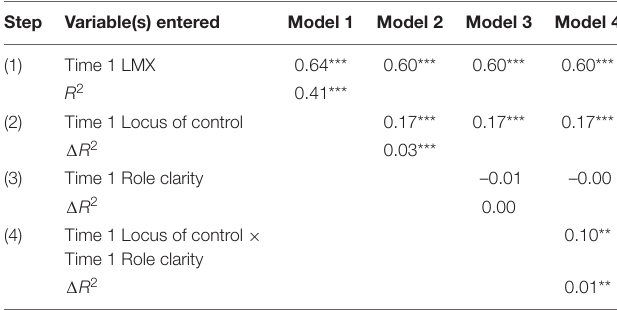
TABLE 3 | Results of moderated linear regression analysis for Time 2 overall